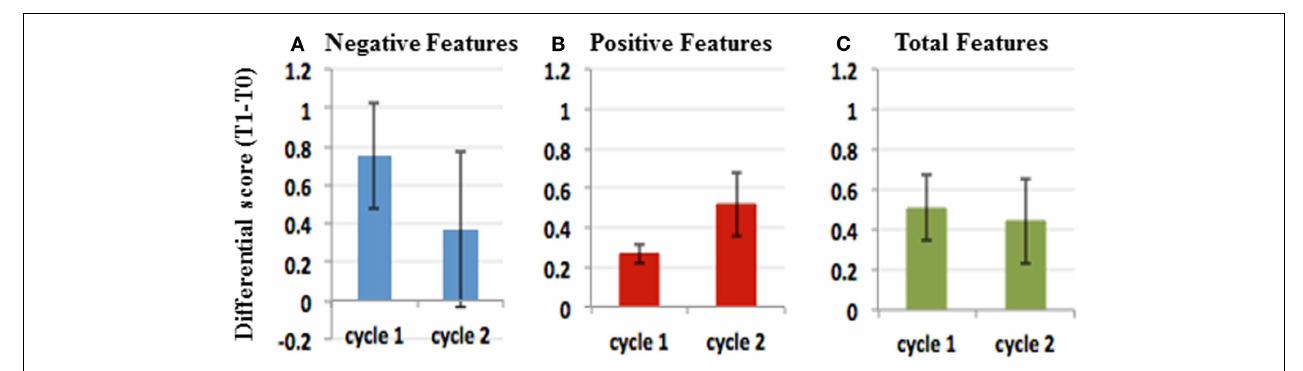
in the first cycle than in the second (A) . Conversely, the positive features improved more in the second cycle than the first. (B) Considering both positive and negative features, the effect of the treatment was comparable in both cycles (C)